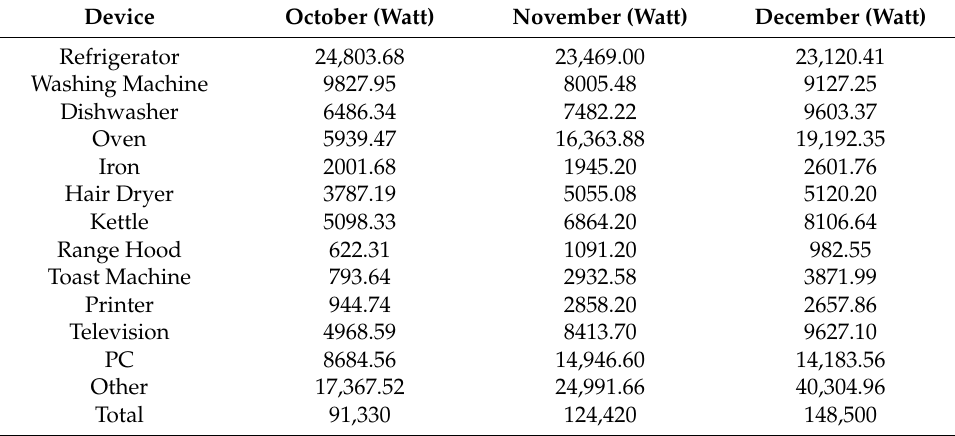
Table 3. The total power consumption of home appliances from October to December.